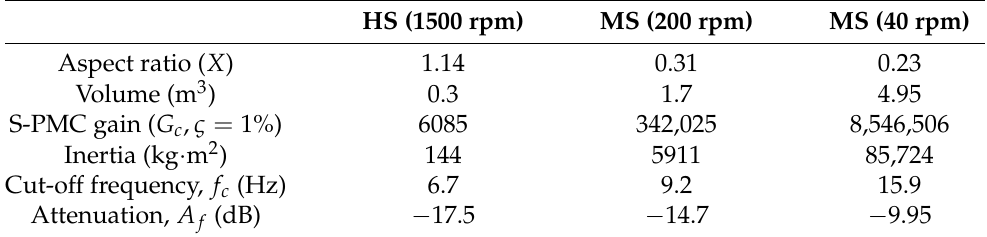
Table 2. Comparison between the considered high-speed (HS) SS-WTS and two medium-speed (MS) SS-WTS